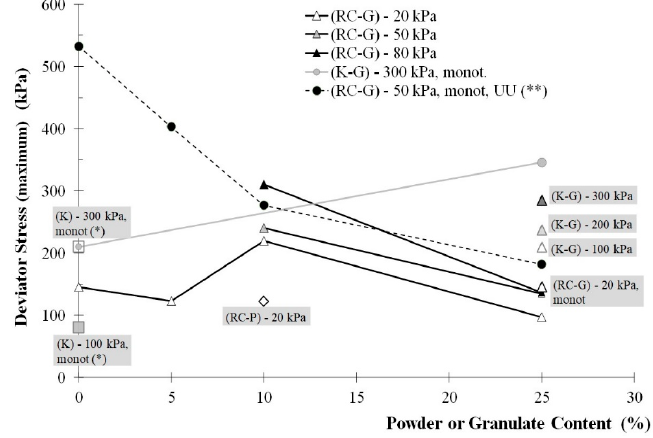
Figure 10. Deviator stress at failure q max versus powder or granulate levels for (RC-R) and (K-R) mixtures and the kaolin (K) and red clay (RC) (based on this study and tests reported in [30,51]). * Jastrz˛ebska’s tests [51], ** Jastrz˛ebska’s tests [30]. The points indicating the single tests are described separately (next to the markers). The description of the test series for different rubber waste levels and an identical confining pressure (the corresponding curves) is included in the legend.